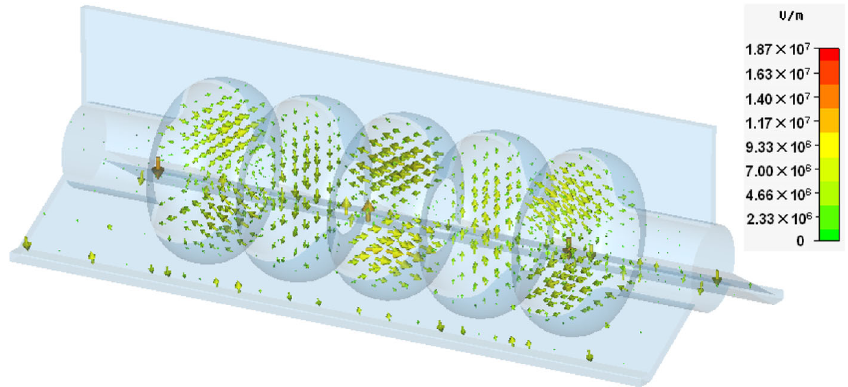
cavity.FIG. 5. (Color) E -field of a dipole mode in the slotted cavity. Frequency ¼ 1 : 972 99 GHz , Q e ¼ 1 : 02 , R=Q ¼ 22 : 7 (cid:1) . The electric field is derived by assuming 1 J stored energy of this dipole mode in the cavity.